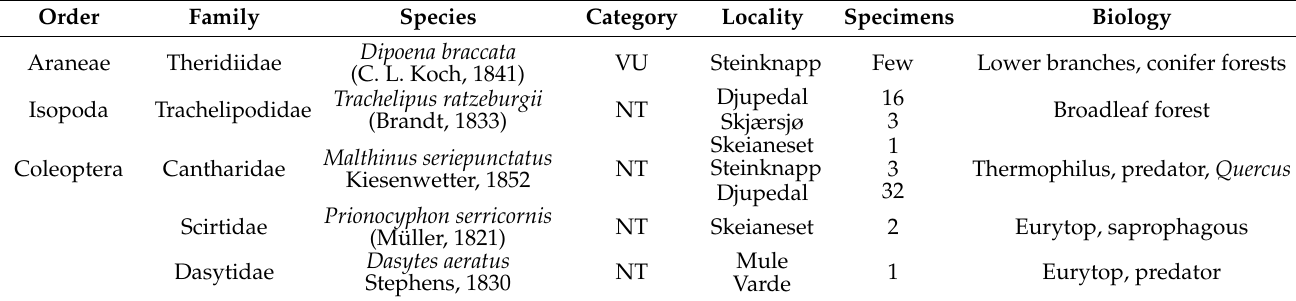
Table 3. Red listed species [61]. Categories: VU = vulnerable, NT = near threatened.